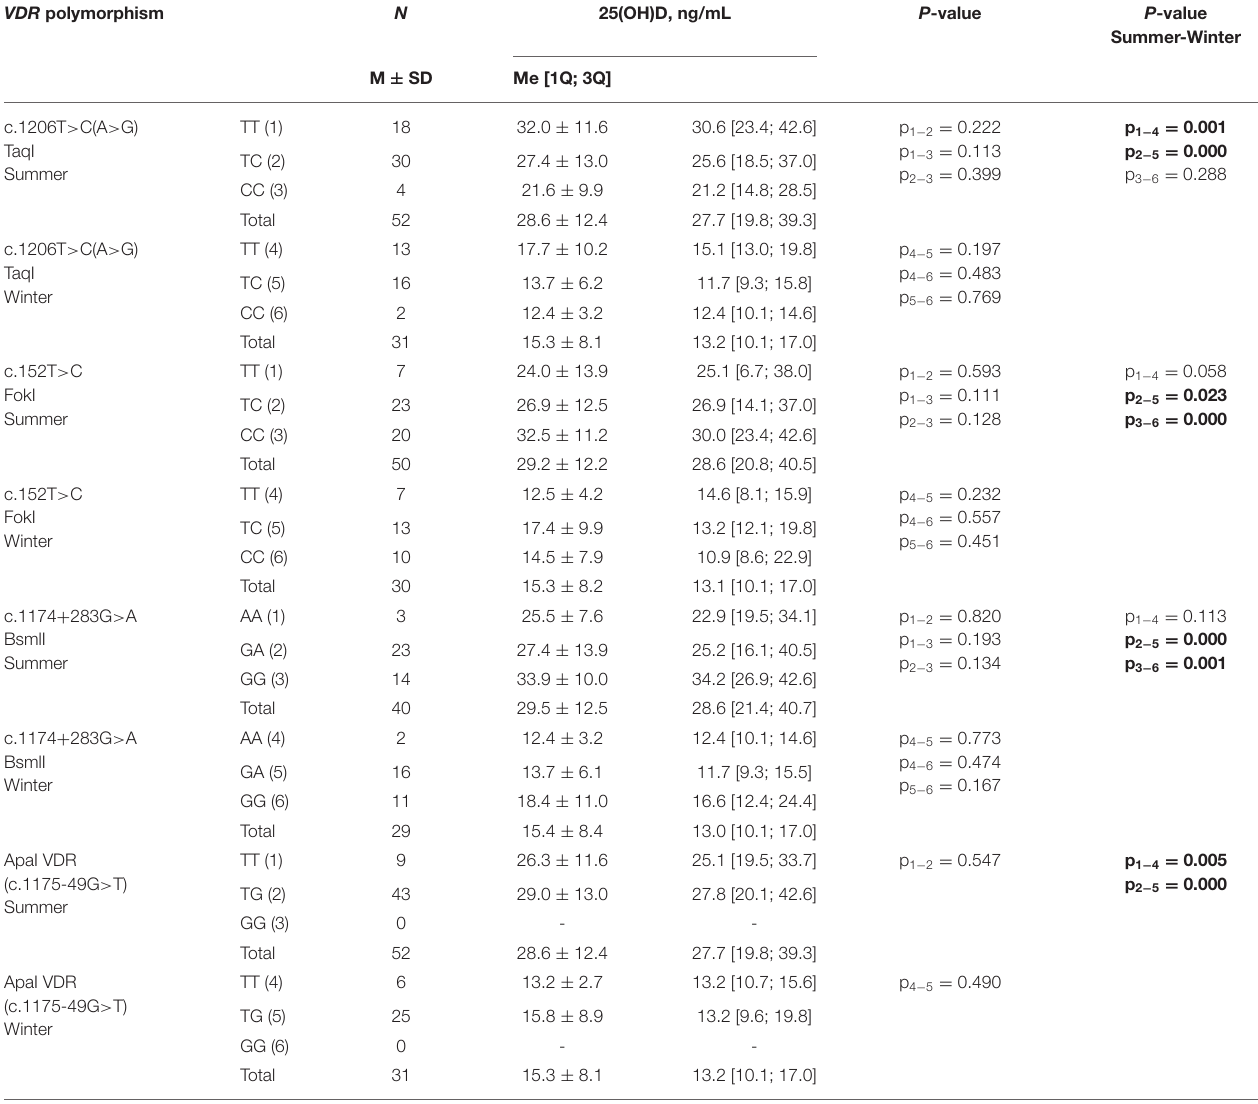
TABLE 8 | Serum calcidiol level among patients with JIA who did not receive vitamin D supplementation, as a function of the genotypes of polymorphisms of the VDR gene, in winter and summer. VDR